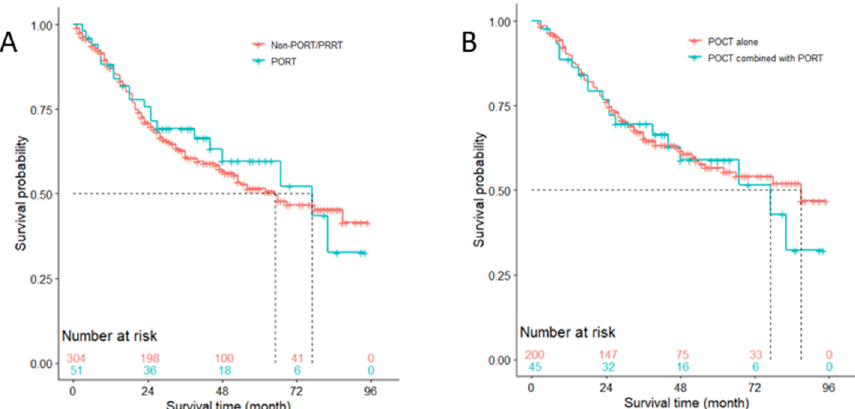
Figure 5. Overall survival of patients with N1 stage featured with ≥ 3 positive lymph nodes ( A ) who received Non-PORT/PRRT versus PORT ( p = 0.610); ( B ) who received POCT alone versus POCT combined with PORT ( p = 0.919). Note: POCT = postoperative chemotherapy; PORT = postoperative radiotherapy; PRRT = preoperative radiotherapy; Non-PORT/PRRT = neither PORT nor PRRT.